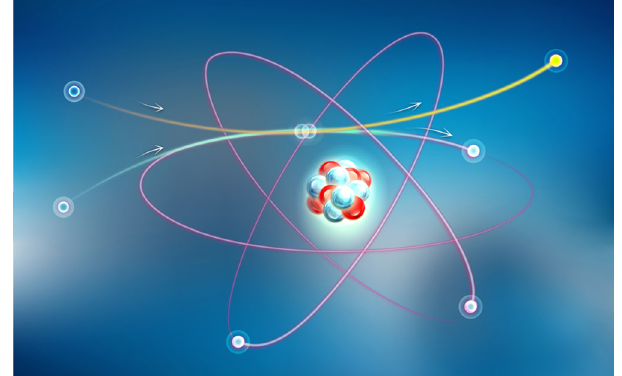
Fig. 1 The scheme of a three-body recombination process. An electron transfers its energy and momentum to another free electron nearby and then recombines to the target ion with a speci fi c bound state. Note that the recombined electron can produce a negative-energy electron around the target